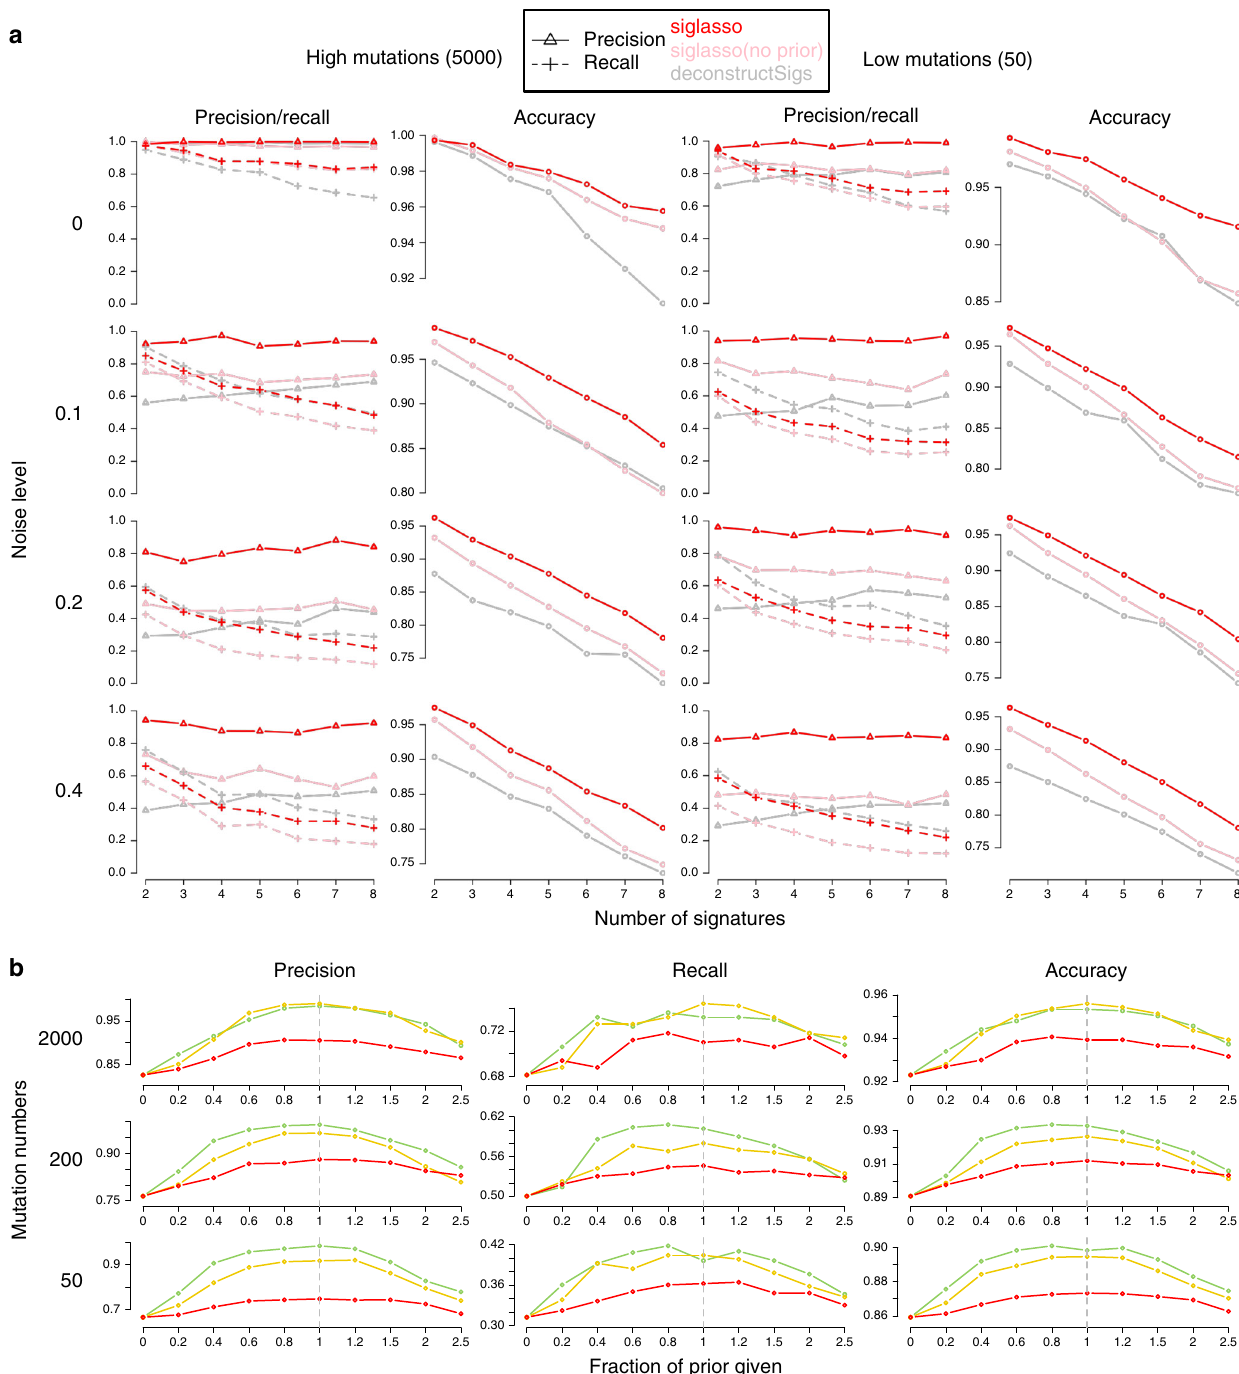
Fig. 2 Performance on simulated data sets. a Support recovery on simulated data sets. Each setting is simulated 100 times. Penalty coef fi cients for priors: 0.1. b Support recovery on simulated data sets. Tuning the penalty weights using prior knowledge improves performance; x axis: the fraction of true signatures given as prior (larger than 1 indicates false signatures giving as priors). Penalty coef fi cients for priors: red, 0.5; yellow, 0.1; green,